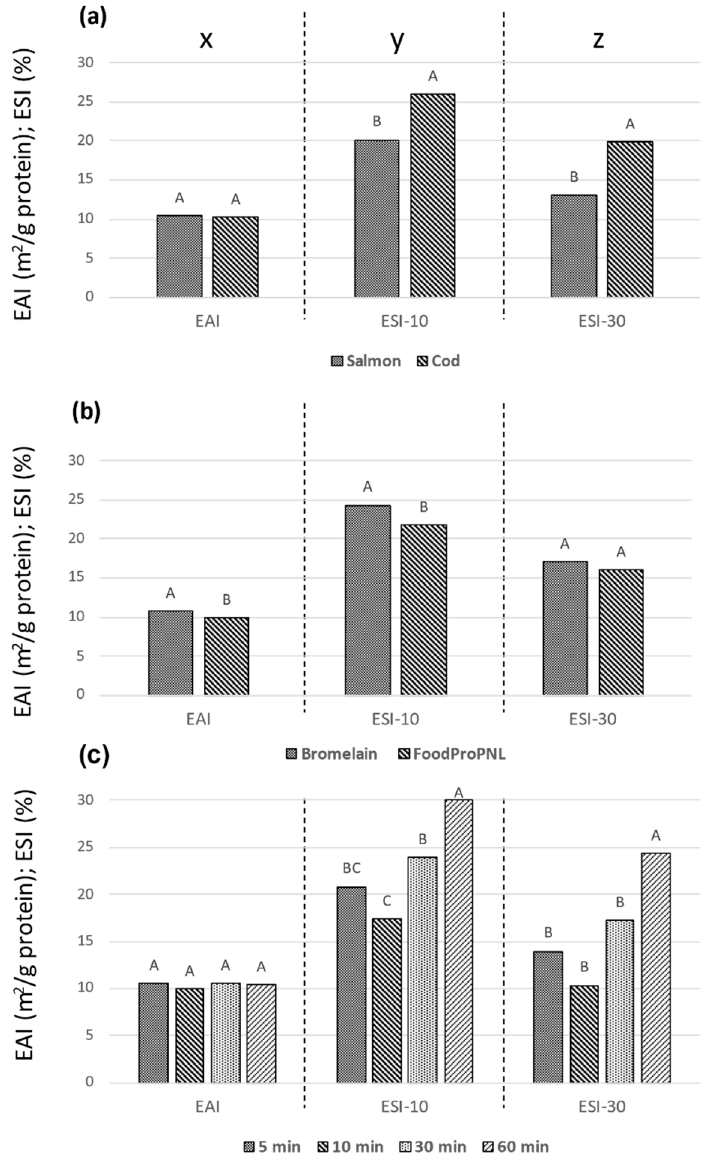
Figure 2. Mean emulsion activity index (EAI) and emulsion stability index (ESI) after 10 and 30 min for the raw materials salmon and cod ( a ), the enzymes FoodPro PNL and Bromelain ( b ), and hydrolysis times ( c ). Different letters indicate statistical effect of the hydrolysis parameter on the emulsion variable. EAI (x), EAI-10 (y) and EAI-30 (z) are separate statistical entities, indicated by the dotted lines.